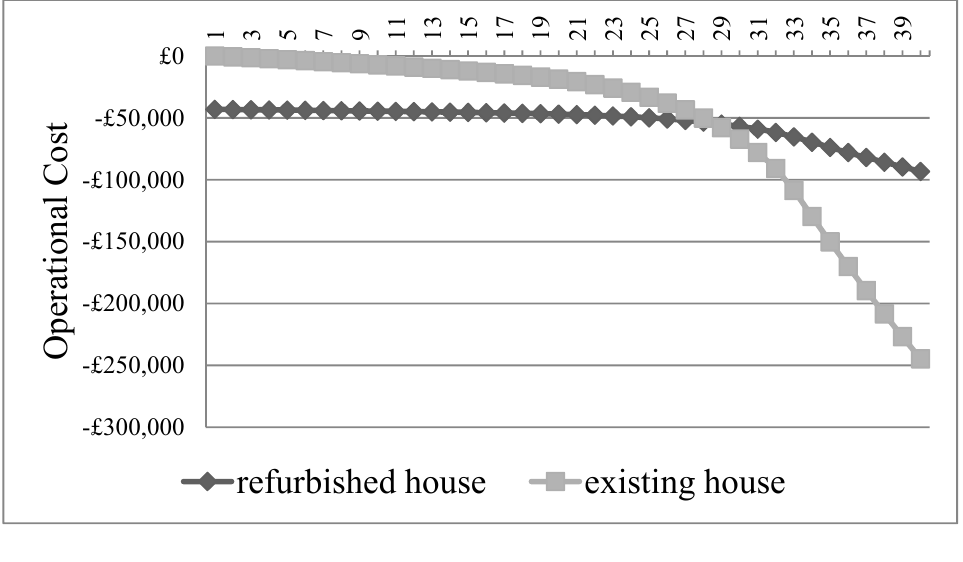
Figure 22. Comparison of the pre and post refurbished house’s cumulative discounted operational costs for Edinburgh current and future weather data over 40 years imposing an upward gas price